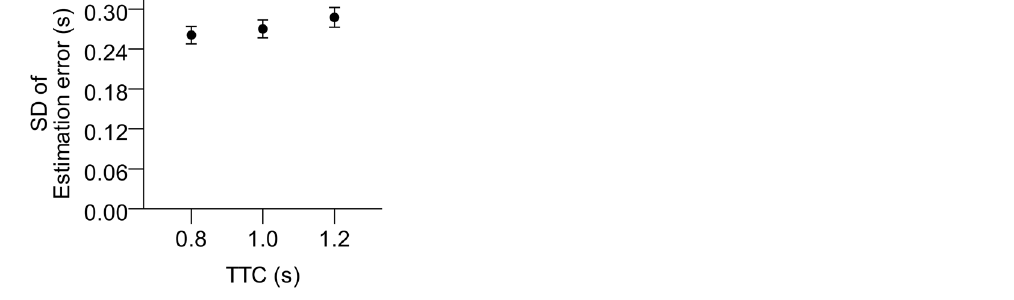
Figure 5. Mean standard deviation ( SD ) of TTC estimation errors (variable error) as a function of actual TTC. Error bars represent ± 1 standard error of the mean across